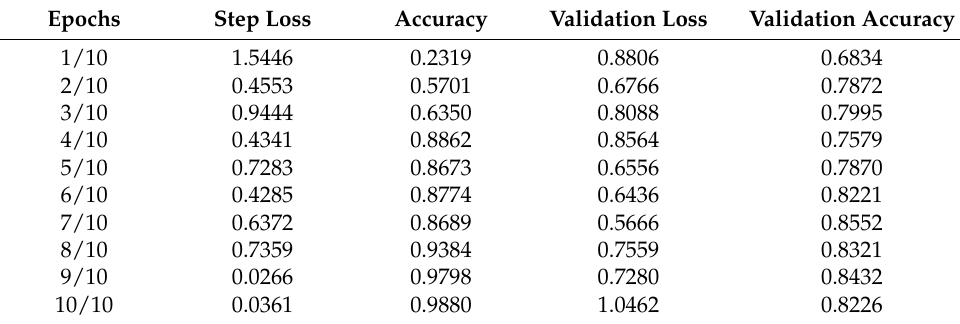
Table 4. Prescriptive data analysis for Conv2D ResNet model compilation.